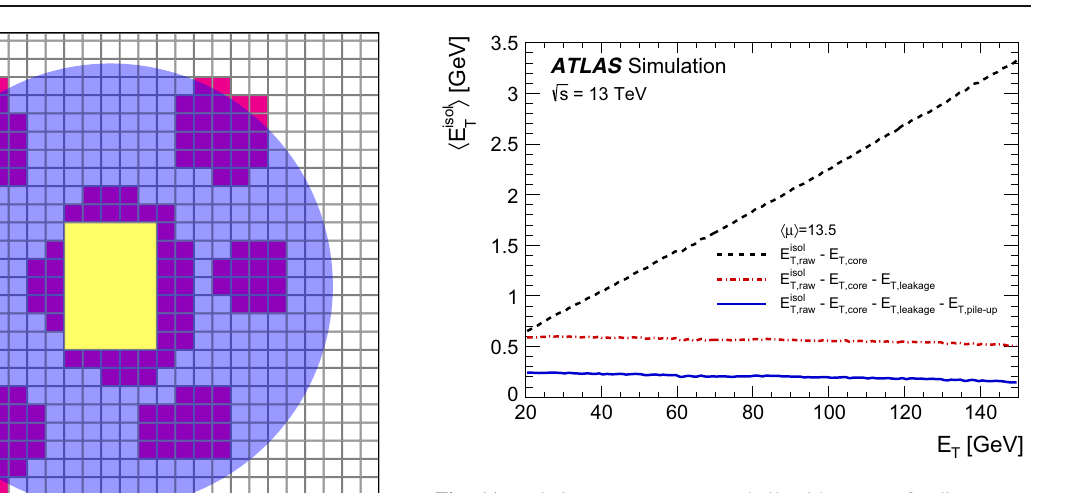
Fig. 11 Isolation transverse energy built with a cone of radius (cid:7) R = 0 . 2, corrected with a rectangular core without (black dashed line) and with(reddot-dashedline)theleakagecorrection E T , leakage asafunction η of the electron E T , for a simulated sample with electron candidates in the central region of the detector ( | η | < 2 . 47) that satisfy a Tight electron identification criterion. This figure also shows the size of the pile-up correction E T,pile-up (the difference between the red dot-dashed line and solid blue line). The curves were obtained from a simulated single-electron sample that includes the effects of (cid:4) μ (cid:5) = 13 . 5